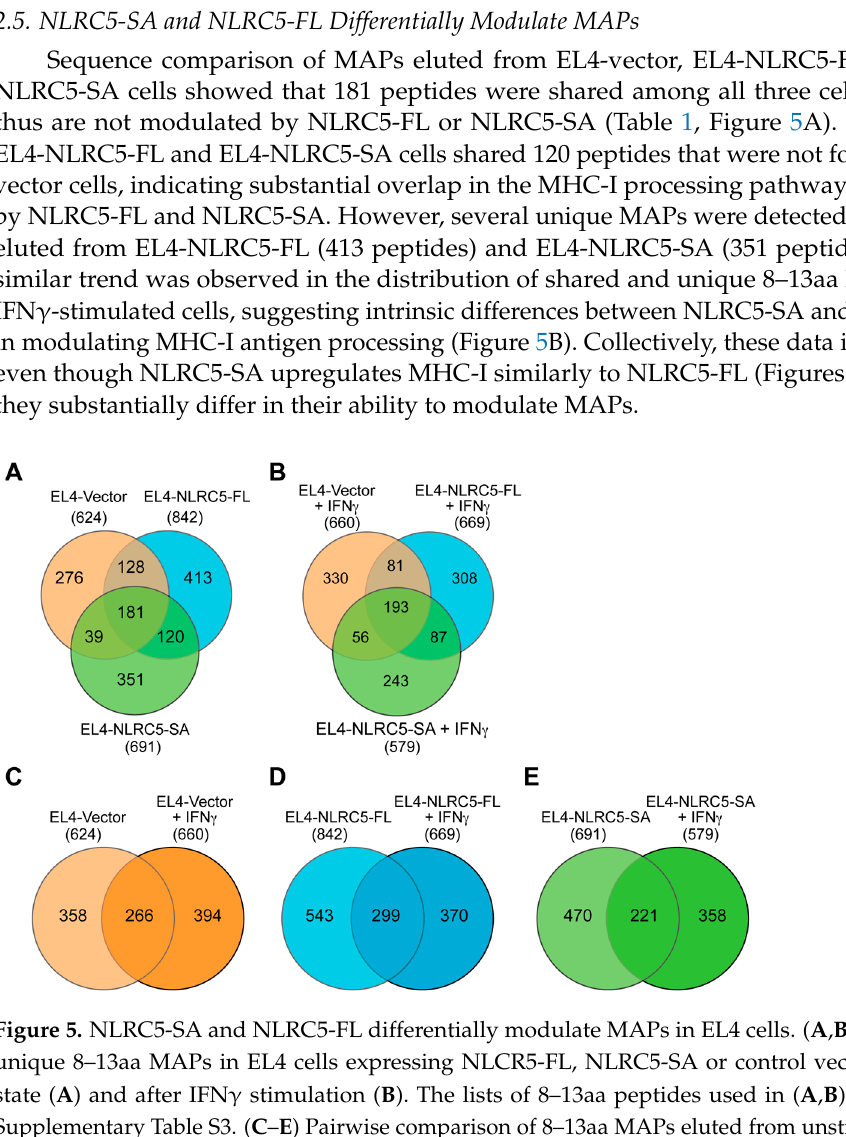
peptides eluted from the three cell lines before and after IFN γ stimulation (Figure 5C–E). IFN γ caused substantial changes in the MAP pro fi le of EL4-vector cells, with ~60%